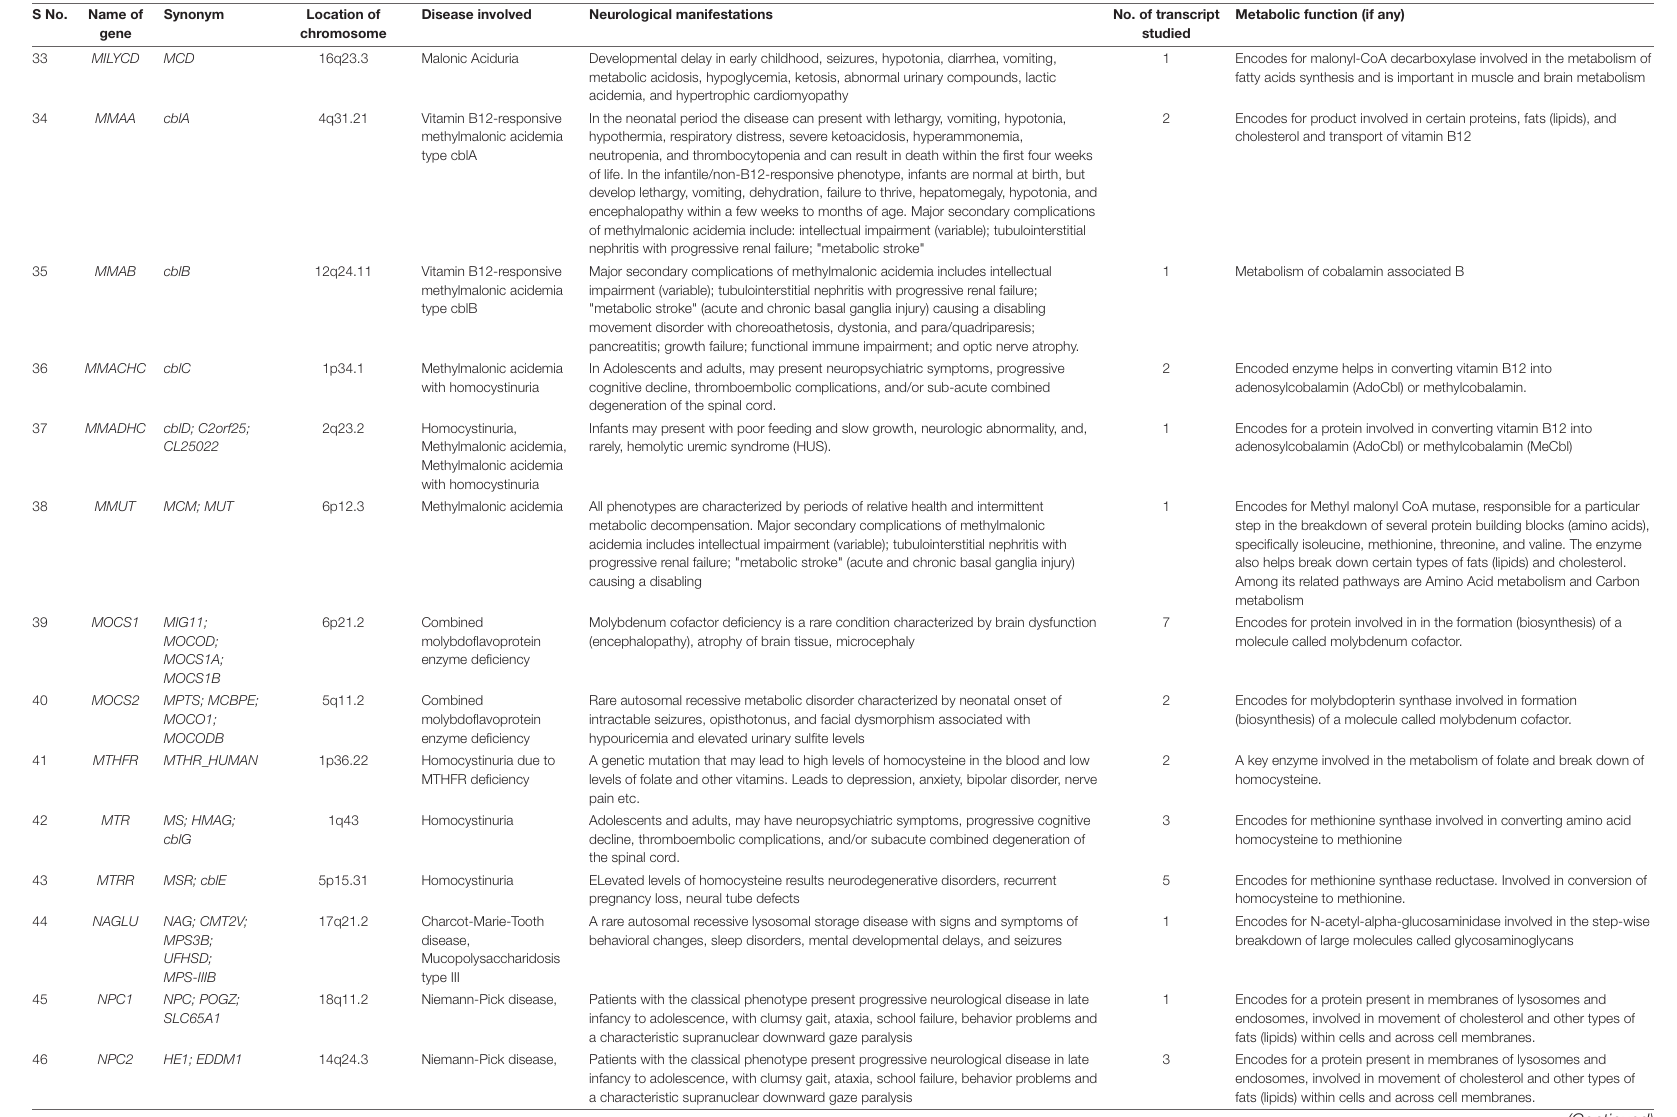
46 Encodes for a protein present in membranes of lysosomes and